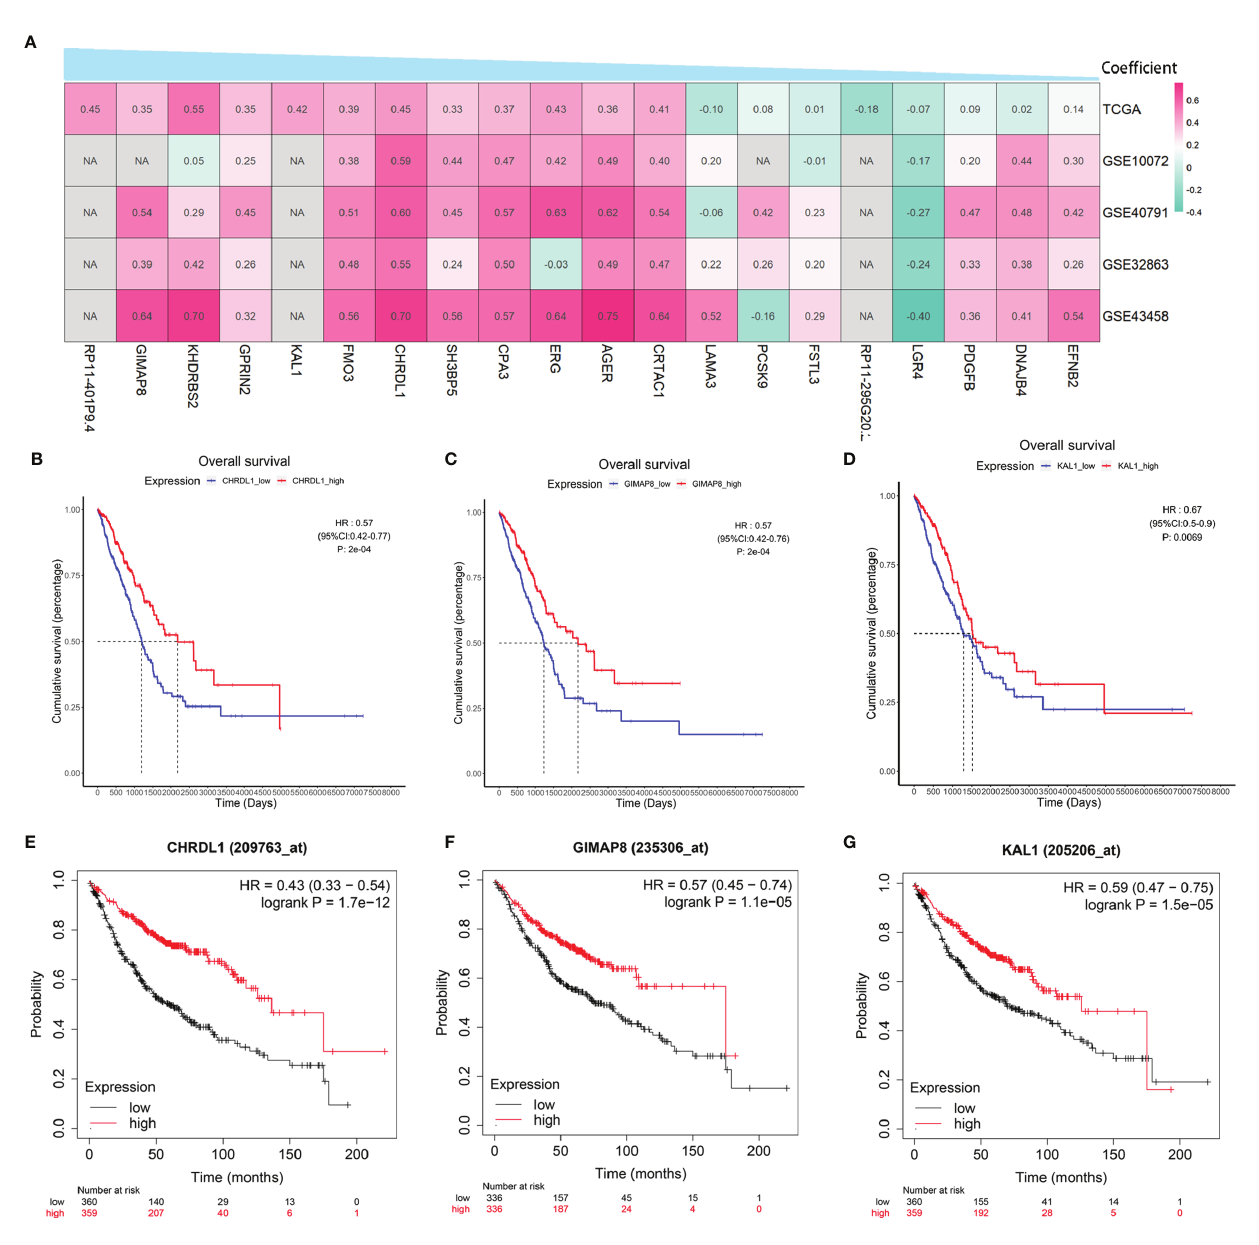
FIGURE 8 | The correlation with BMP5 and prognostic value of hub genes in the re-established risk model. (A) Correlation heatmap of 20 hub genes with BMP5 in TCGA-LUAD and four GEO datasets. (B – D) The Kaplan – Meier curves of CHRDL1, GIMAP8, and KAL1 in the tumor samples of TCGA-LUAD ( n = 513). CHRDL1 (HR: 0.57, 95% CI: 0.42 – 0.77, p : 2e-04 < 0.001), GIMAP8 (HR: 0.57, 95% CI: 0.42 – 0.76, p : 2e-04 < 0.001), and KAL1 (HR: 0.67, 95% CI: 0.50 – 0.90, p : 0.0069 < 0.001). (E – G) The Kaplan – Meier curves of CHRDL1, GIMAP8, and KAL1 in lung adenocarcinoma of Kaplan – Meier plotter ( n = 719). CHRDL1 (HR: 0.43, 95% CI: 0.33 – 0.54, p : 1.7e-12 < 0.001), GIMAP8 (HR: 0.57, 95% CI: 0.45 – 0.74, p : 1.1e-05 < 0.001), and KAL1 (HR: 0.59, 95% CI: 0.47 – 0.75, p : 1.5e-05 < 0.001). NA, not